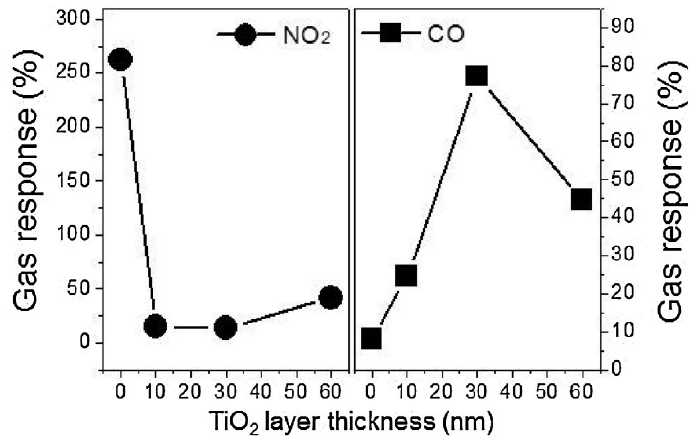
Figure 14. Response of TiO 2 -layer-modified SnO 2 QDs to NO 2 and CO gases (1 ppm) at 300 °C [116]. For modified QDs, heterojunctions were formed and potential barriers were created.